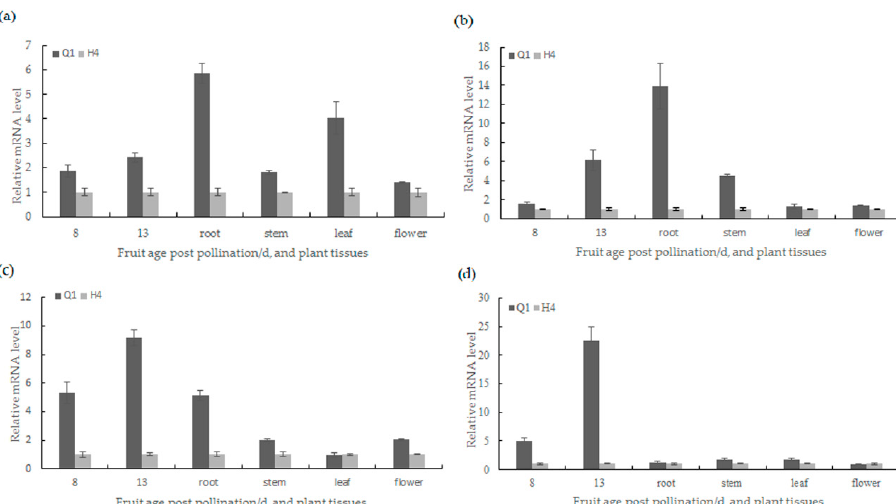
Figure 6. Quantitative real-time PCR analysis of candidate gene in tissues between Q1 and H4: ( a ) relative mRNA levels of the Csa3G904080 gene in different tissues; ( b ) relative mRNA levels of the Csa3G904110 gene in different tissues; ( c ) relative mRNA levels of the Csa3G904130 gene in different tissues; ( d ) relative mRNA levels of the Csa3G904140 gene in different tissues.